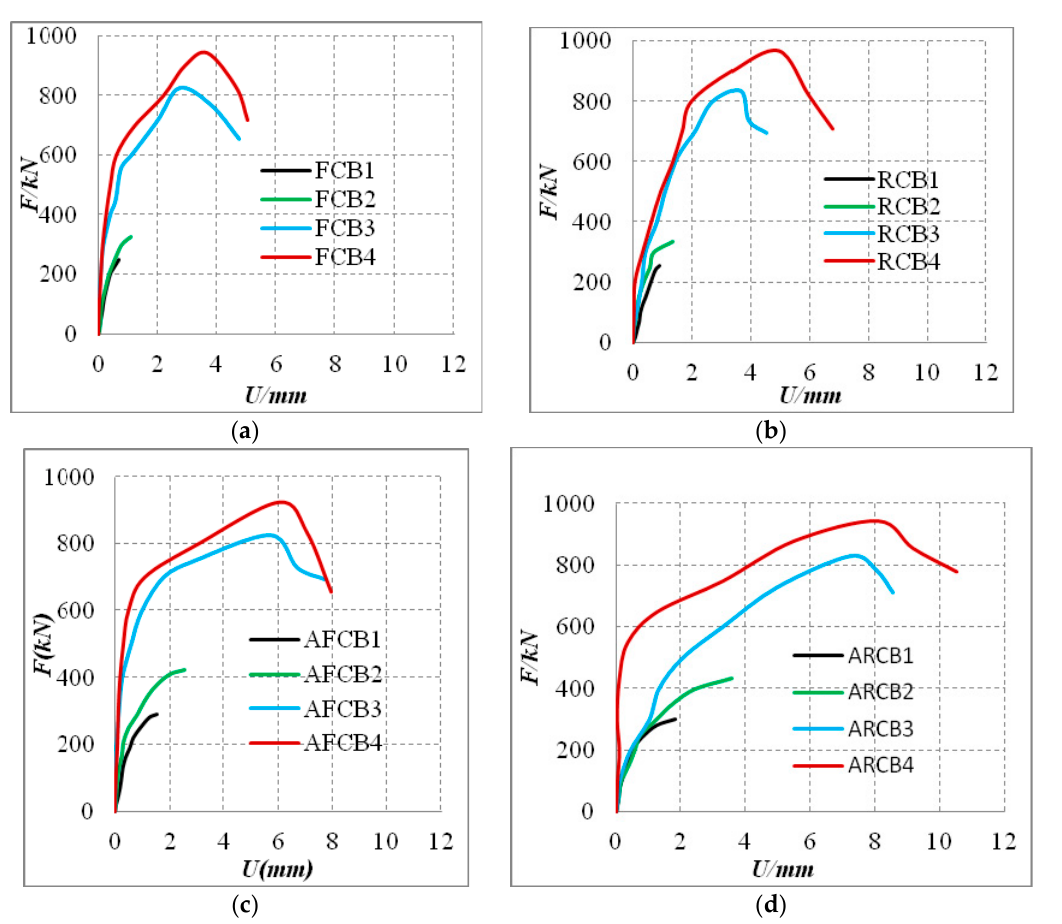
Figure 9. Axial loading ‐ axial displacement curve: ( a ) Group One; ( b ) Group Two; ( c ) Group three; and ( d ) Group four.